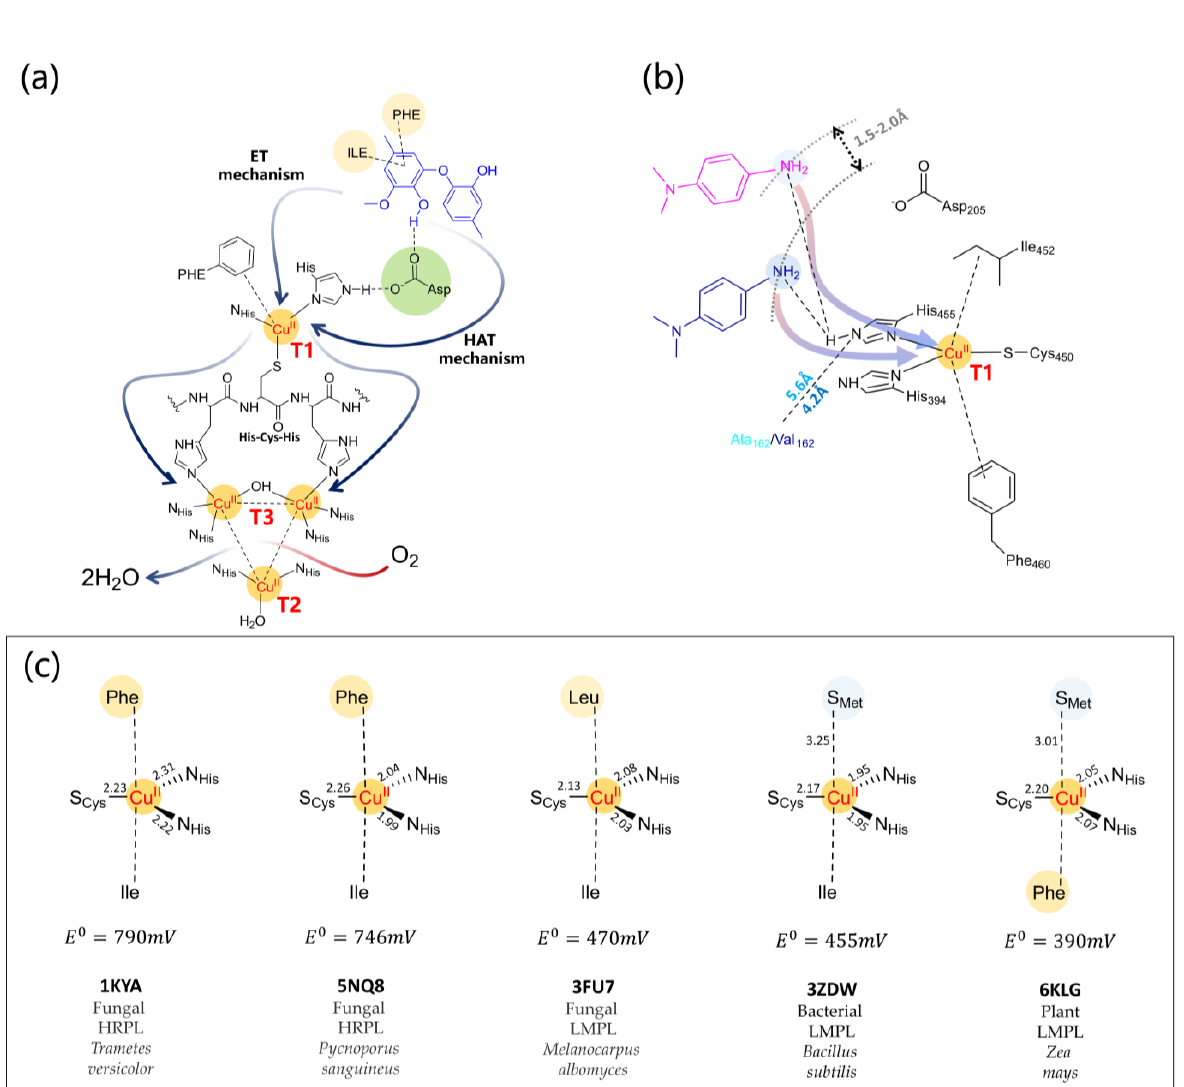
Figure 7. ( a ) Active site of a fungal laccase bound to the di-lignol model guaiacyl 4-O-5 dimer (in blue) as proposed in [168] considering 1KYA [147] Trametes versicolor laccase. The ligand is placed around 7.6 Å from the T1 Cu. Around the ligand are Phe and Ile hydrophobic interaction, the H-bond between Asp227 with one phenolic OH group. Blue arrows depict the intramolecular electron transfer from the substrate to T1 Cu and successively from T1 Cu to T2/T3 centers throughout the very conserved HCH motif. T1-T2 distance is 12–13 Å and T2-T3 3.5–4.0 Å. The substrate oxidation mechanism depends on the nature of the ligand portion under T1 attack. For phenolic portions, a H atom transfer (HAT) through Asp/Glu side chain assisted by the His residues of the T1 Cu coordination has been proposed [157,158]. For non-phenolic portions, a direct electron transfer (ET) to T1 Cu was proposed. The O 2 channel is oriented toward one of the T3 Cu centers [121]. ( b ) Scheme of T1 Cu site of PM1 laccase and 7D5 mutant as described in [169] with the N,N-dimethyl-p-phenylenediamine ligand (in pink). The substrate forms H-bond interactions with the His455 side chain that belongs to the T1 Cu coordination and with Asp205 side chain. The V162A mutation is evidenced and belongs to the loop that defines the binding pocket. Enlarging it, the substrate approach to T1 Cu is favored (see the blue sketch of the substrate), and thus the catalytic efficiency of the mutated enzyme is increased. The distance between the nearest carbon atom of the Val/Asp side chain is taken from PDB 5ANH (PM1) and 6H5Y (7D5) [170]. ( c ) T1 coordination as a function of redox potential, spanning from fungal HRPL to fungal, bacterial, and plant LMPL. This last is referred to as the laccase from Rhus vernificera . Bond distances (in Å) are obtained from the corresponding PDB.